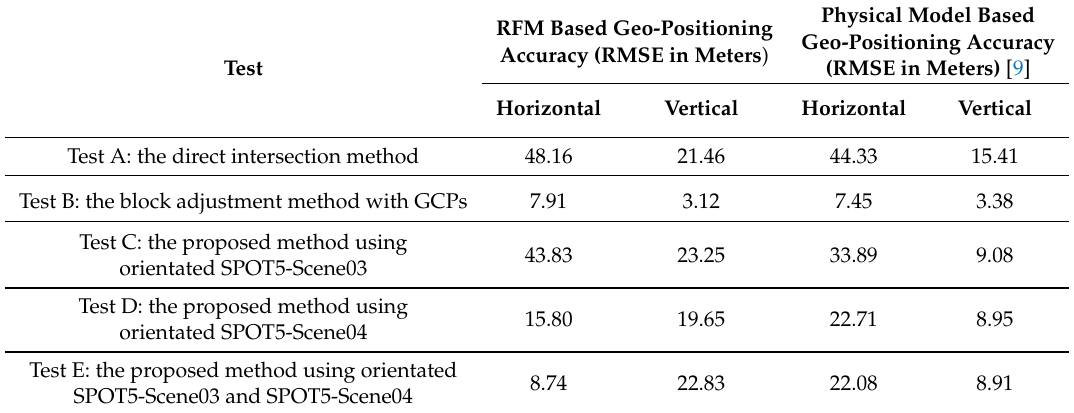
physical model based